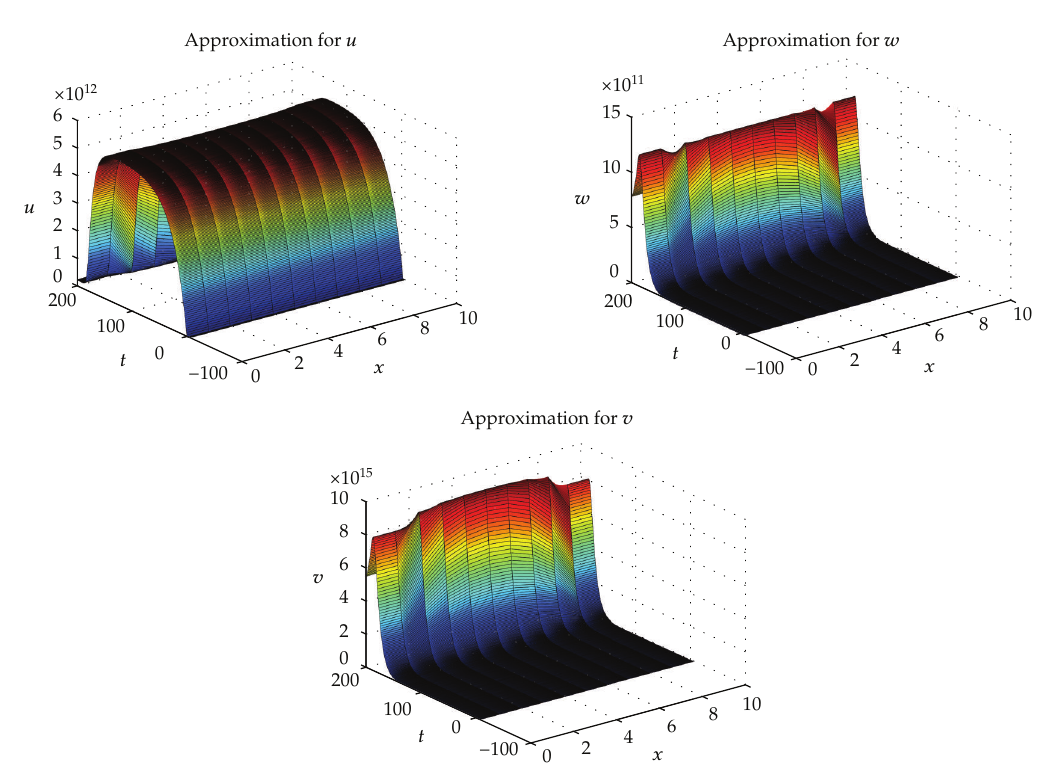
Figure 2: Simulations with parameters L (cid:8) 2 11 , d (cid:8) 3 . 78 − 2 , a (cid:8) 3 . 38 d , p (cid:8) 0 . 67, β (cid:8) 1 . 45 − 4 , k (cid:8) 5 . 18 × 10 3 , (cid:8) 3 . m (cid:8) 0 . 2, and D (cid:8) 0 . 1. R 0